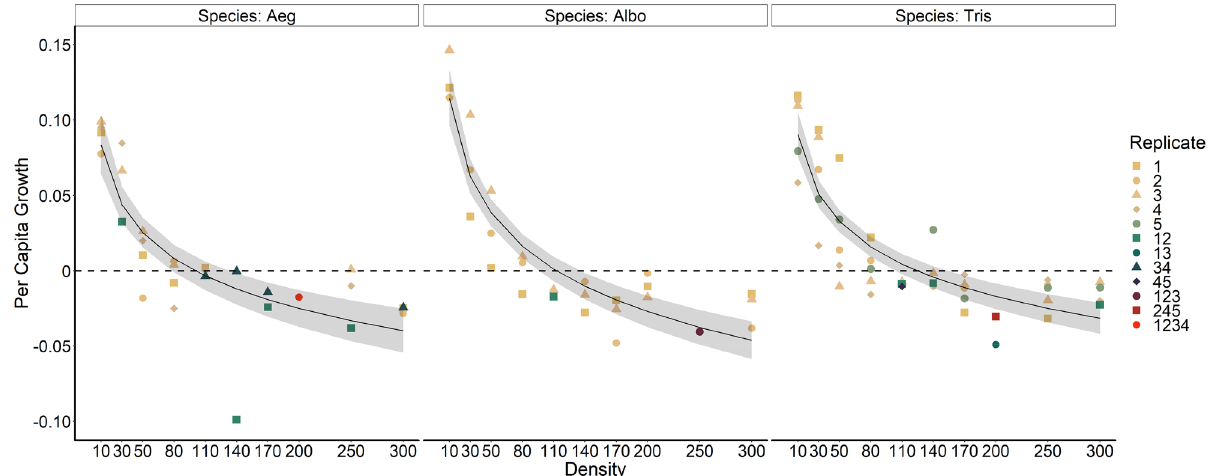
Figure 1. Relationship between estimated per capita rate of change r’ and initial density N for Aedes aegypti, Aedes albopictus, and Aedes triseriatus , as described by the best models (Table 1), which were Gompertz models without random variation due to blocks. The solid black line is the predictions from the model averages, and the grey area represents 95% maximum likelihood confidence interval on the prediction (SAS PROC NLMIXED). Best fit parameters (± SE) for A. aegypti, A. albopictus, and A. triseriatus were: r 0 = 0.167 ± 0.017, 0.223 ± 0.019, and 0.173 ± 0.014, and b = − 0.0363 ± 0.0038, − 0.0472 ± 0.0041, and − 0.0358 ± 0.0032, respectively, respectively. The shape and color of data points corresponds to the different replicate blocks for each species; cases of combined cohorts from different blocks are indicated with multiple numbers (e.g., replicate blocks 13, 123,